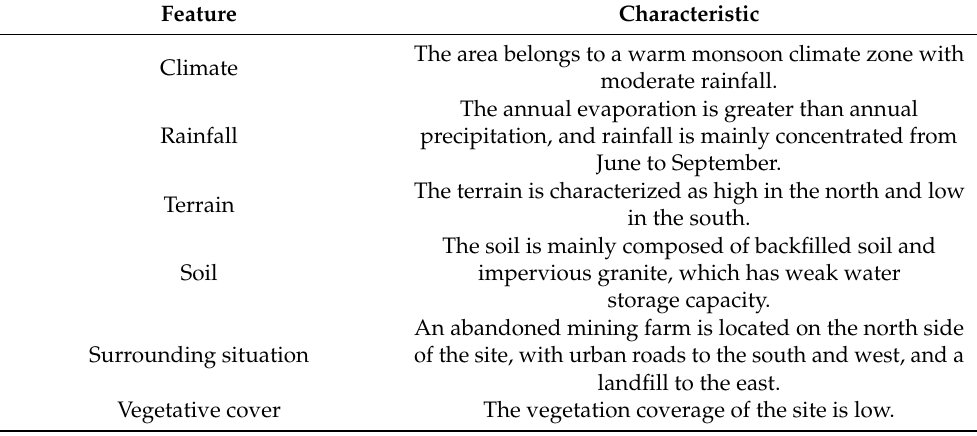
Table 1. Basic characteristics of the study area.